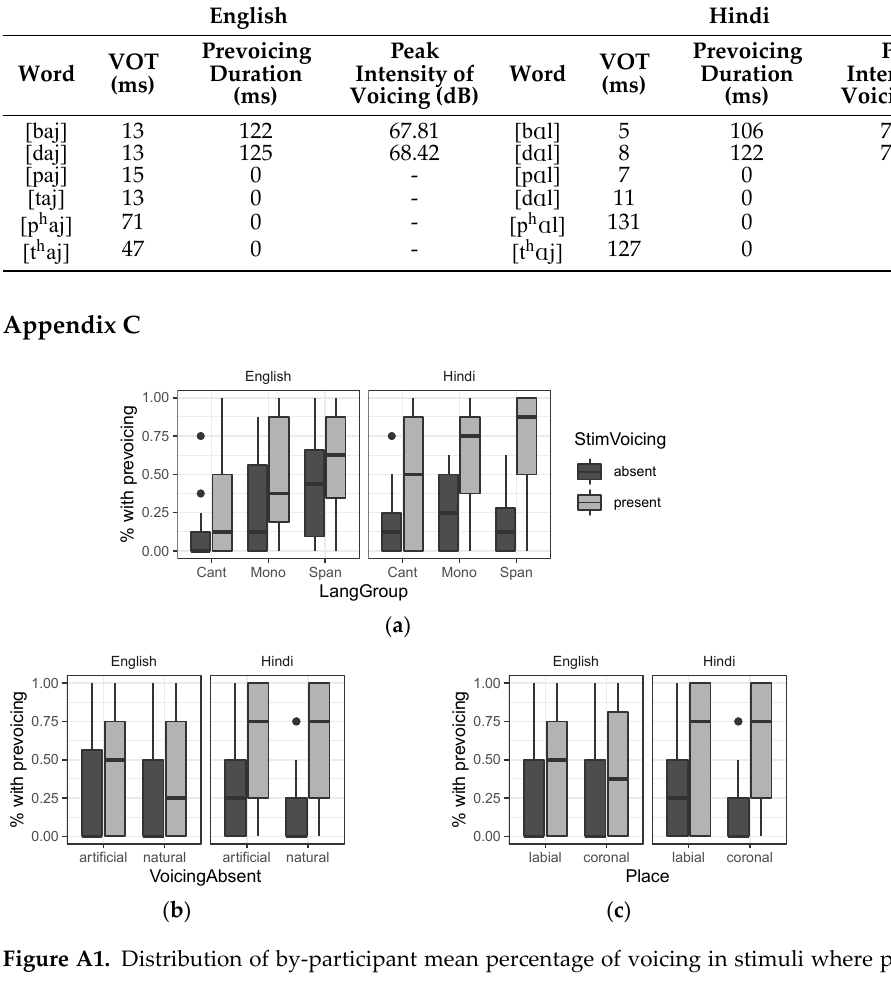
Table A3. Acoustic characteristics (VOT and voicing intensity) of baseline stimuli. All stimuli were normalized to mean 70 dB intensity. For sounds with prevoicing, includes the duration, maximum intensity, and difference between maximum intensity of voicing and maximum intensity of vowels. For all syllables, includes positive voice onset time (duration from beginning of burst to onset of voicing in the following vowel.